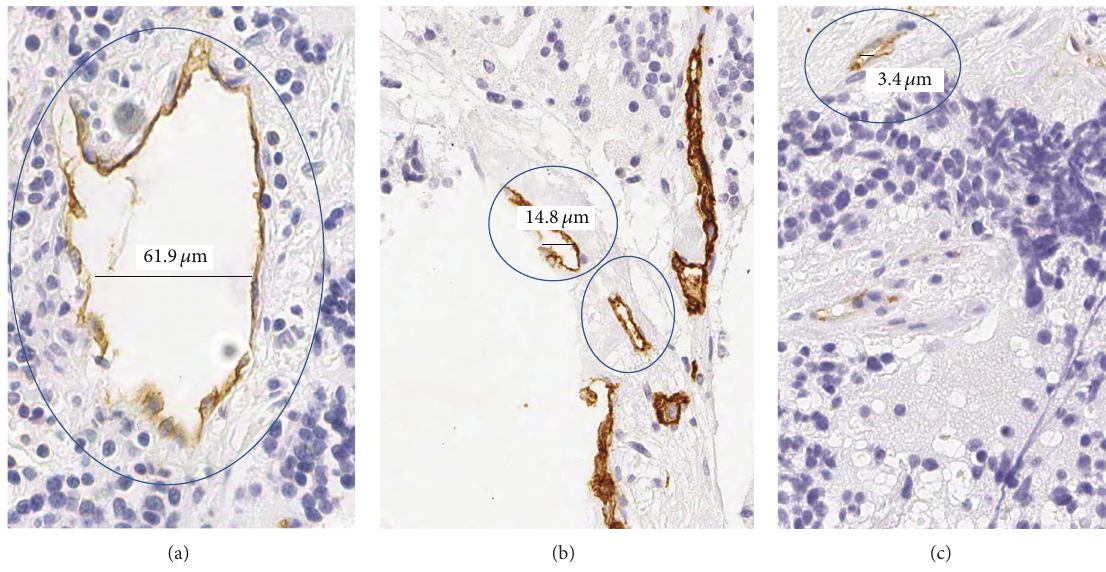
Figure 4: Different size of vessels to calculate the radial